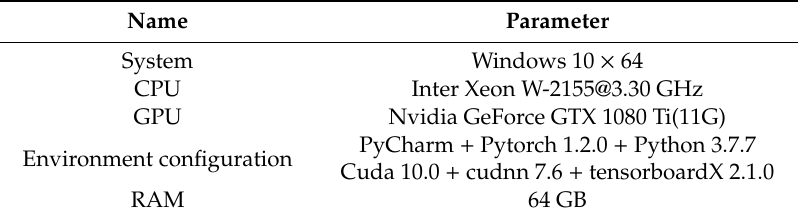
Table 2. Software and hardware environment